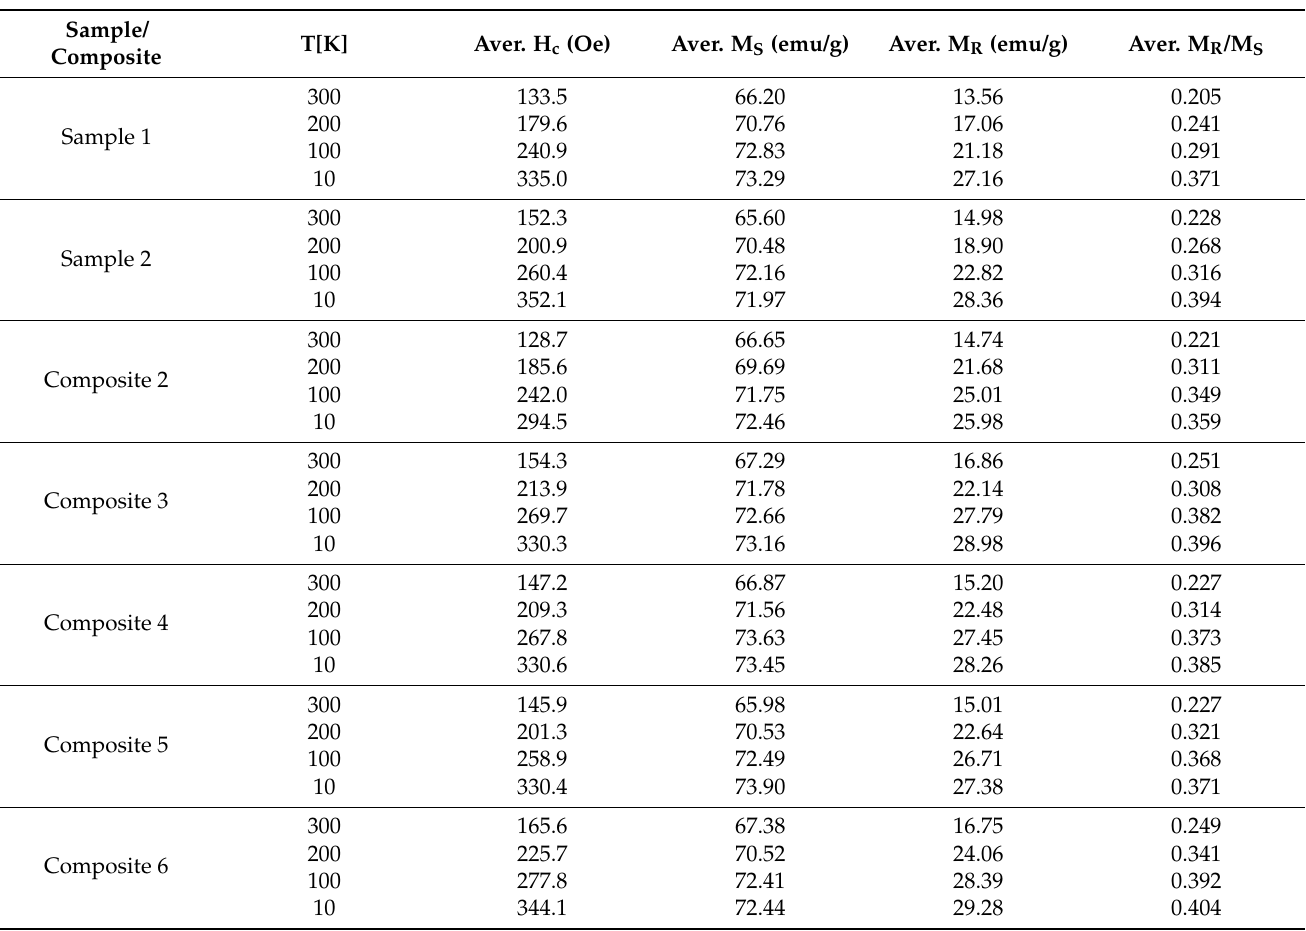
Table 2. Magnetic properties of Samples 1–2 and Composites 2–6. Average M R and M S were normalized by taking the concentration of γ -Fe 2 O 3